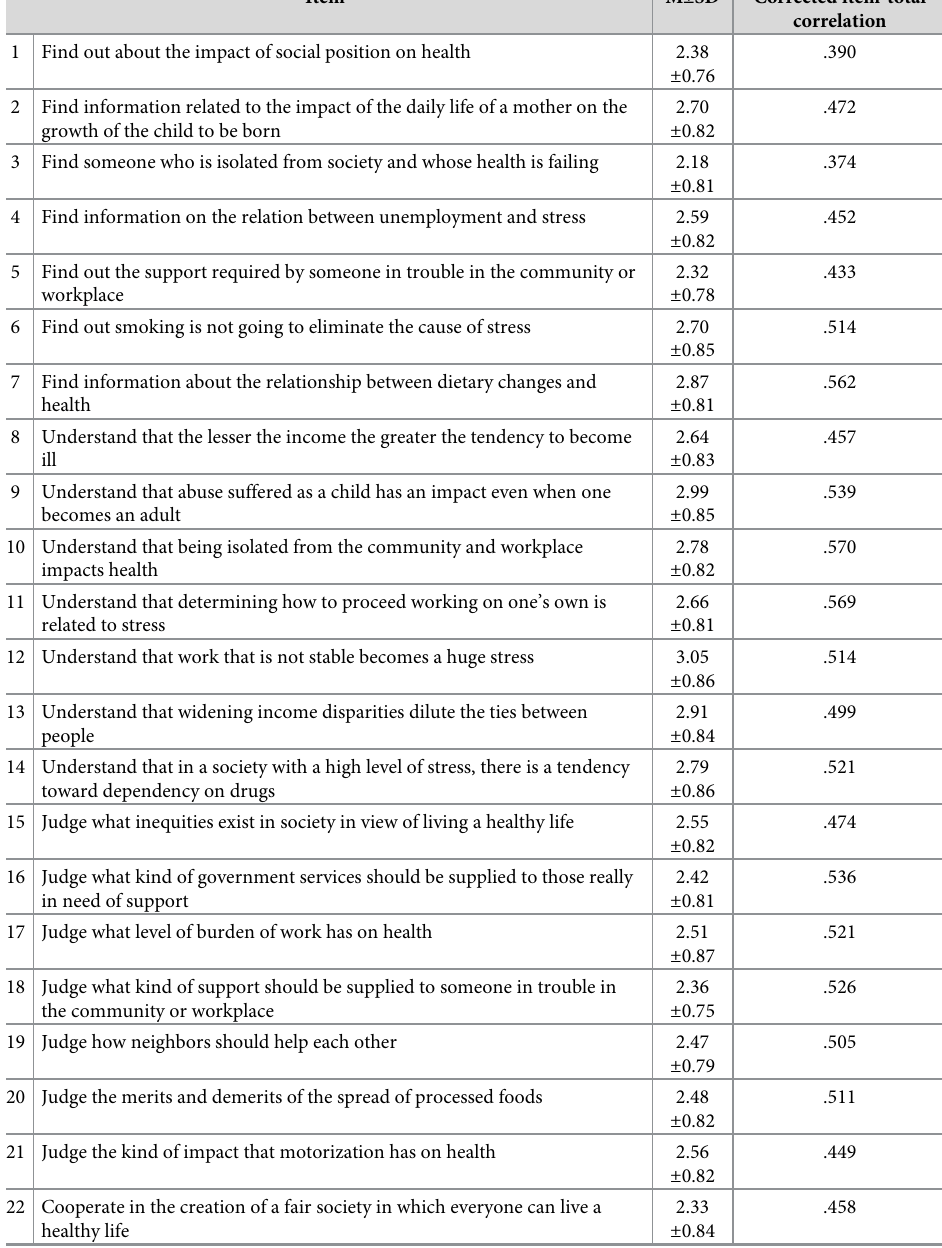
Table 2. Items analysis of the Korean version of the health literacy on social determinants of health questionnaire (HL-SDHQ) scale (n = 660). Item M ± SD Corrected item-total